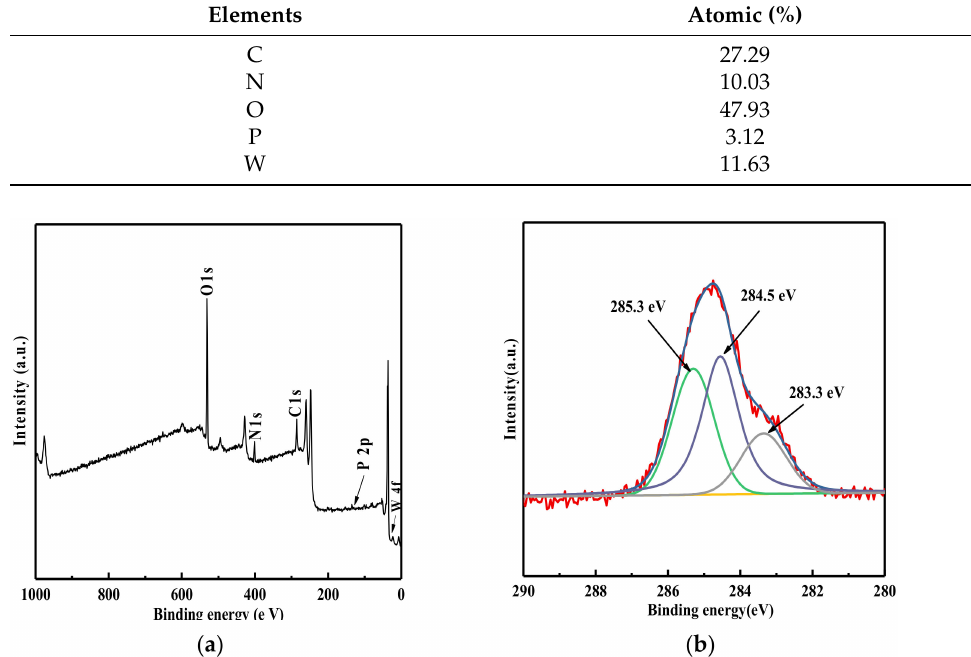
Table 2. Element composition and content of [C 2 (MIM) 2 ]PW 12 O 40.